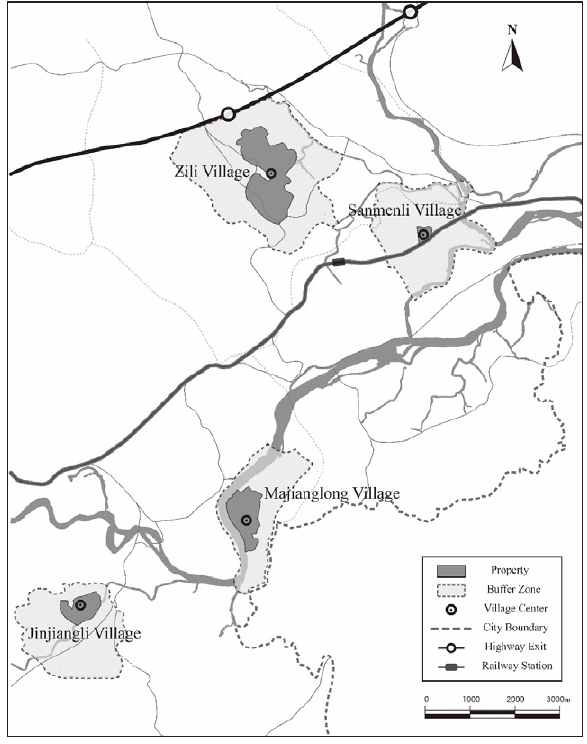
Figure 2. Core area and buffer zones of Kaiping Diaolou and Villages (source: the inscription text of Kaiping Diaolou and Villages) Table 2. Comparison of four villages (source: the inscription text of Kaiping Diaolou and Villages)